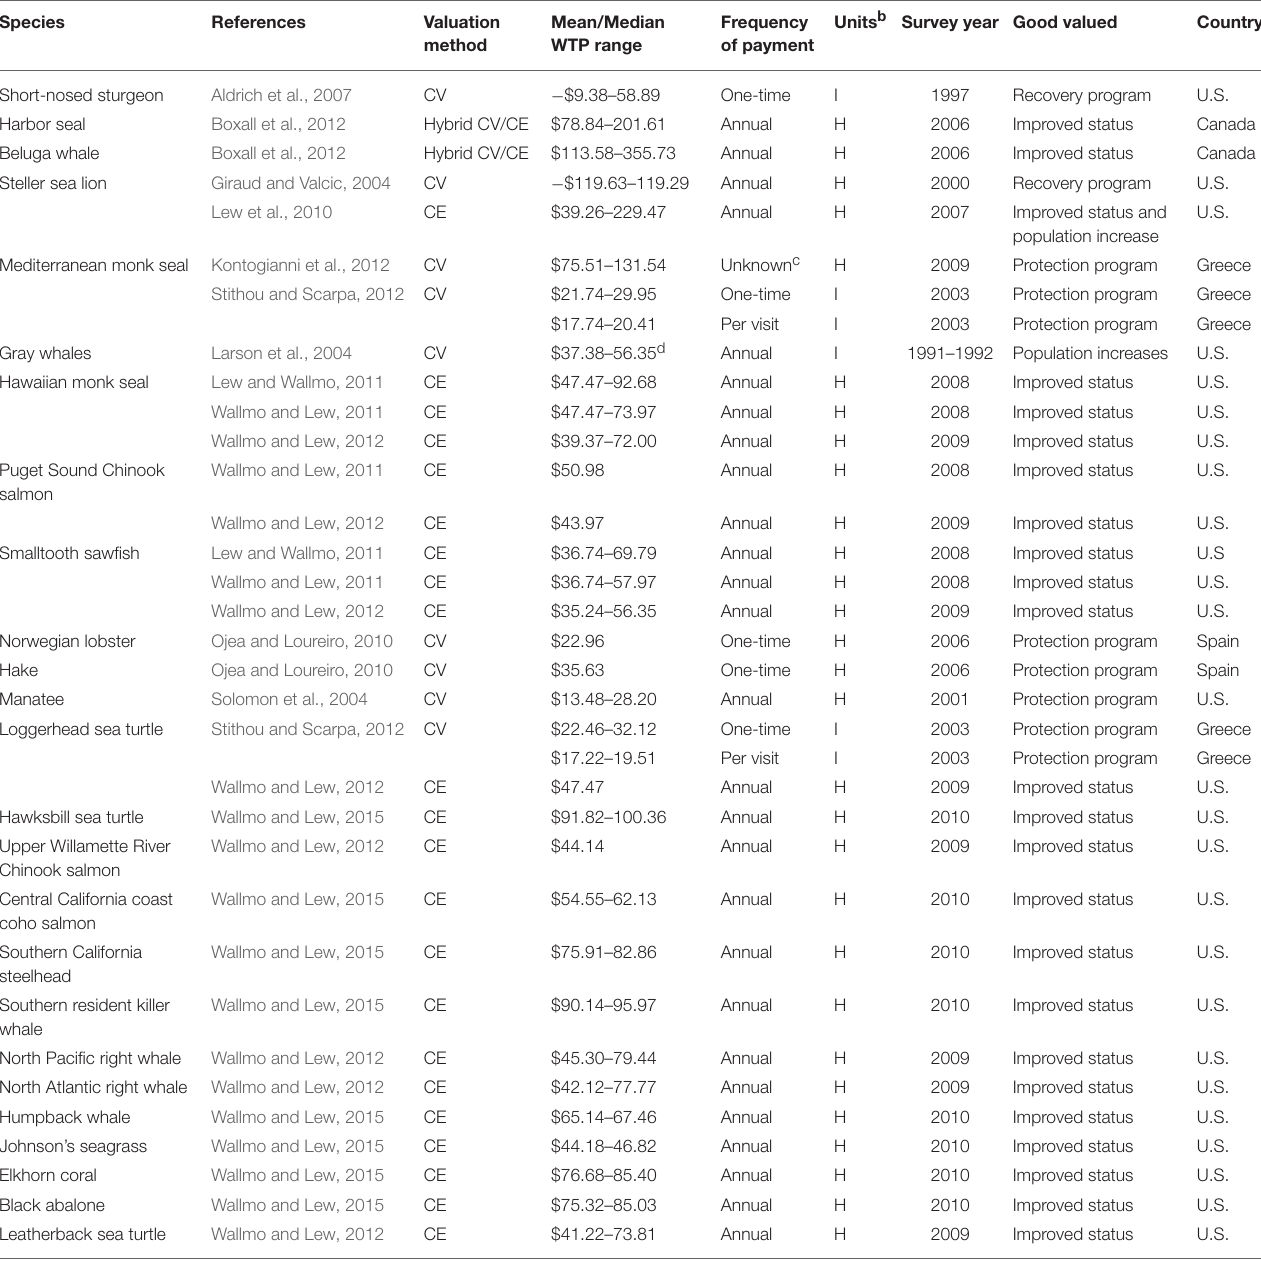
TABLE 2 | Recent disaggregate threatened, endangered, and rare marine species valuation studies a